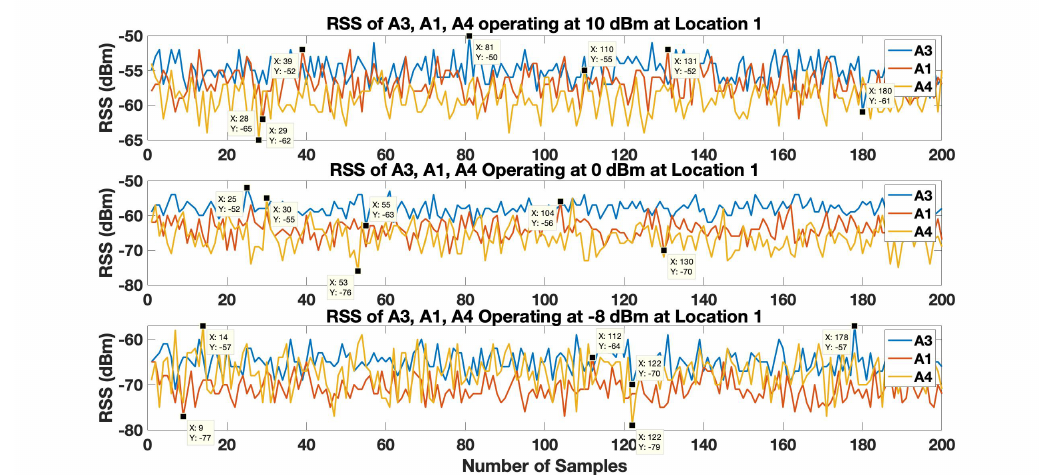
Figure 9. RSS of anchors A 3 , A 1 , and A 4 operating at 10 dBm, 0 dBm and − 8 dBm at Location 1 in Environment